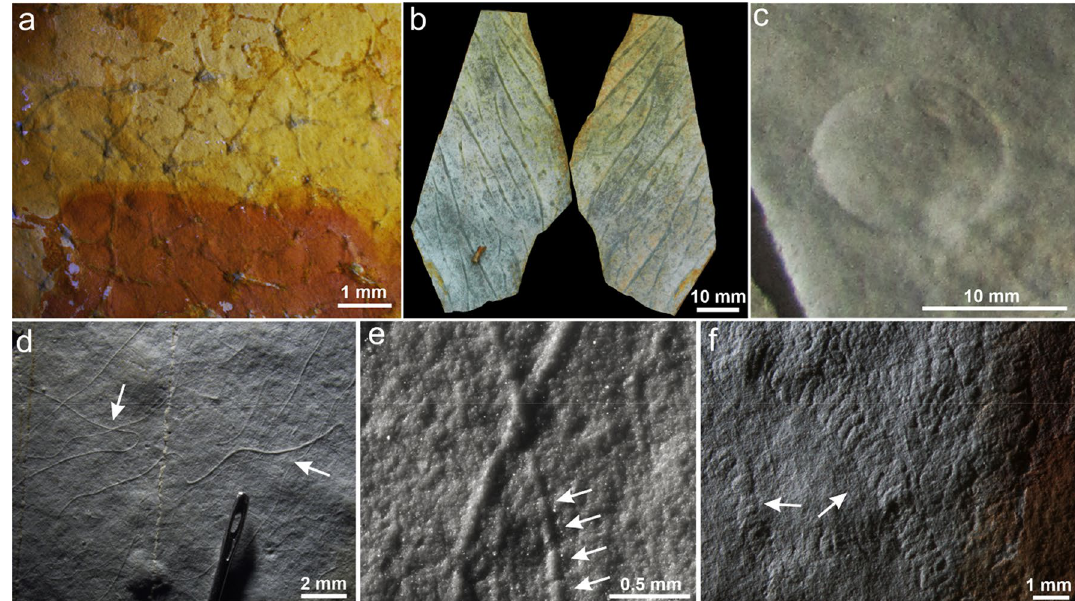
Figure 1. Ediacaran fossils and preservation styles in the Itajaí Basin. ( a ) Three-dimensionally preserved tufted microbial mats (CAP-879). ( b ) 3D Arumberia-type microbial mats (CAP-880). ( c ) Aspidella in positive hyporelief (CAP-549). ( d ) Sub-millimetric to micrometric filaments in positive epirelief (CAP-881). ( e ) Exquisite preservation of filaments bearing putative cellular structures (arrows) (CAP-866). ( f ) Palaeopascichnus in positive epirelief. Image created using Inkscape 1.0 (https ://inksc